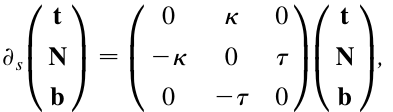
FIG. 2. Probing the different components of a handedness pseudotensor: Air flow past a helicoid. Two identical right- handed helicoidal surfaces, supported by thin cylindrical rods oriented along perpendicular directions, display opposite response to airflow. The helicoids were printed using a three- dimensional printer (Objet Connex350 TM ), and they measure 2 cm wide and (cid:9) cm long. The axis of the first helicoid is oriented along its length (a), whereas the axis of the second helicoid is oriented along the transverse direction (b). The structures were placed in an airflow, and their axes were hinged to allow free rotation about the direction of the flow. (a) As air flows past the longitudinal axis of the helicoid, the latter rotates in a left-handed fashion. (b) The same helicoid rotates in a right- handed fashion when hinged along the perpendicular direction. Surprisingly, the helicoid hinged along the traverse direction rotates faster than the one hinged along its long